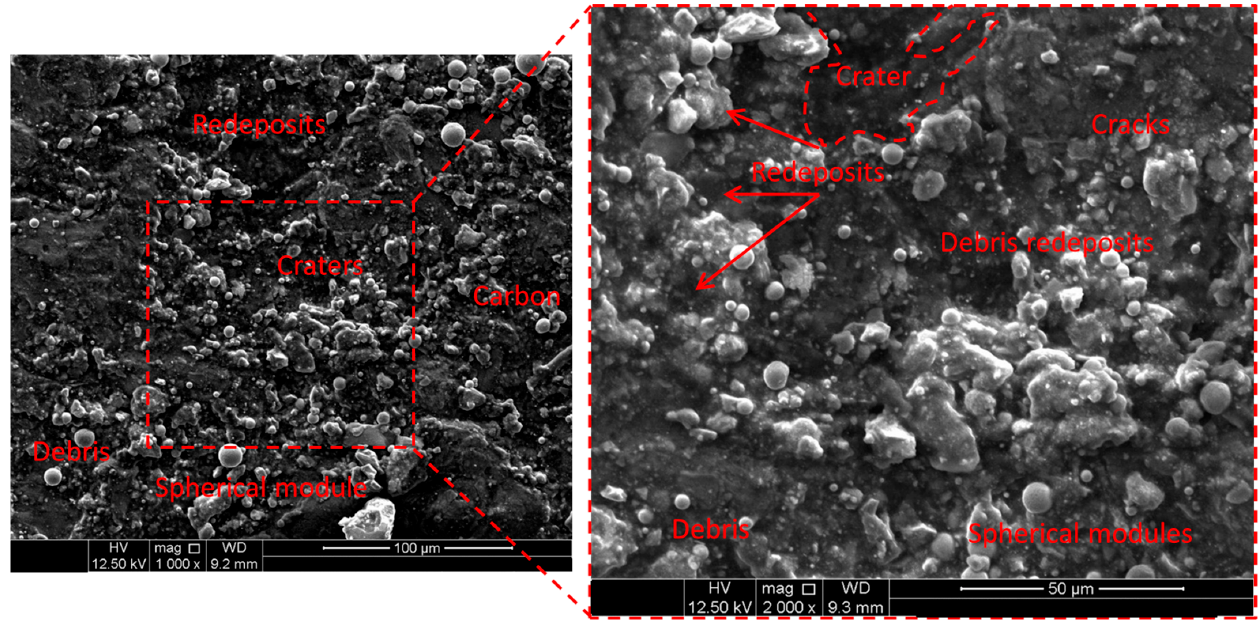
Figure 11. Surface morphology of kerosene-mixed S-80 dielectric at 37.5 g/L, pulse ON:OFF time of 50:100 µSec, and using graphite electrode. 50:100 µ Sec, and using graphite